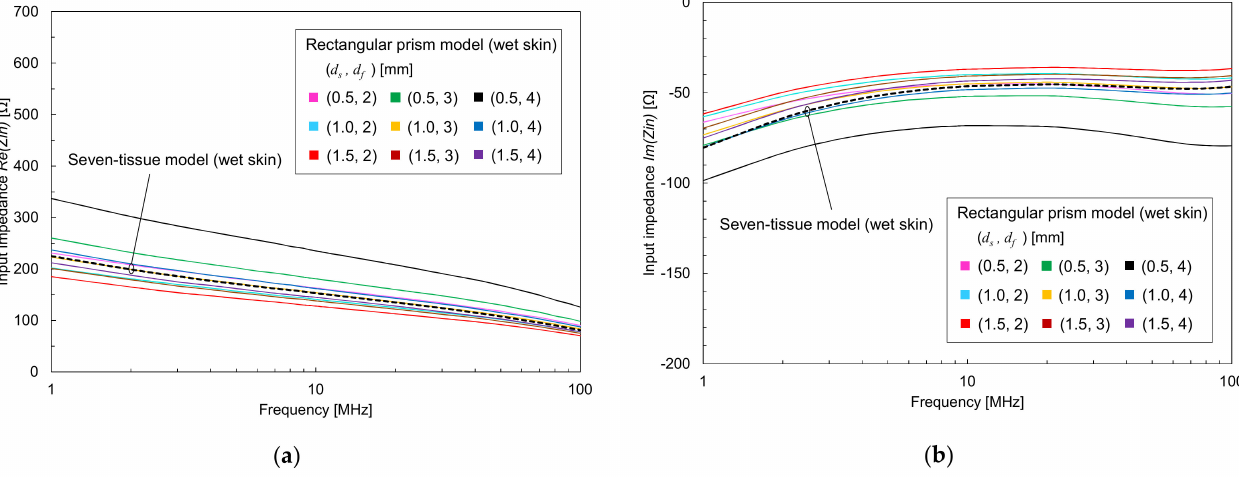
Figure 13. Input impedance characteristics of the wearable antenna calculated by using a simplified rectangular prism model with wet skin: ( a ) Real component of input impedance characteristics; ( b ) imaginary component of input impedance